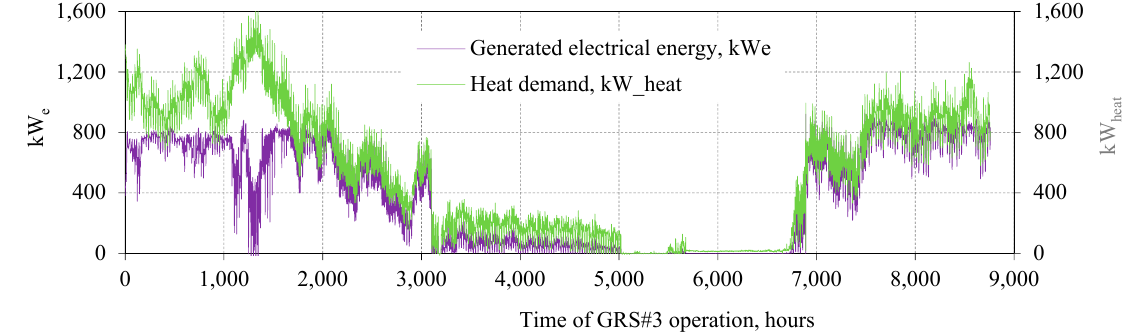
Figure 12. Generated electrical energy and heat demand at GRS #3 over a period of one year.